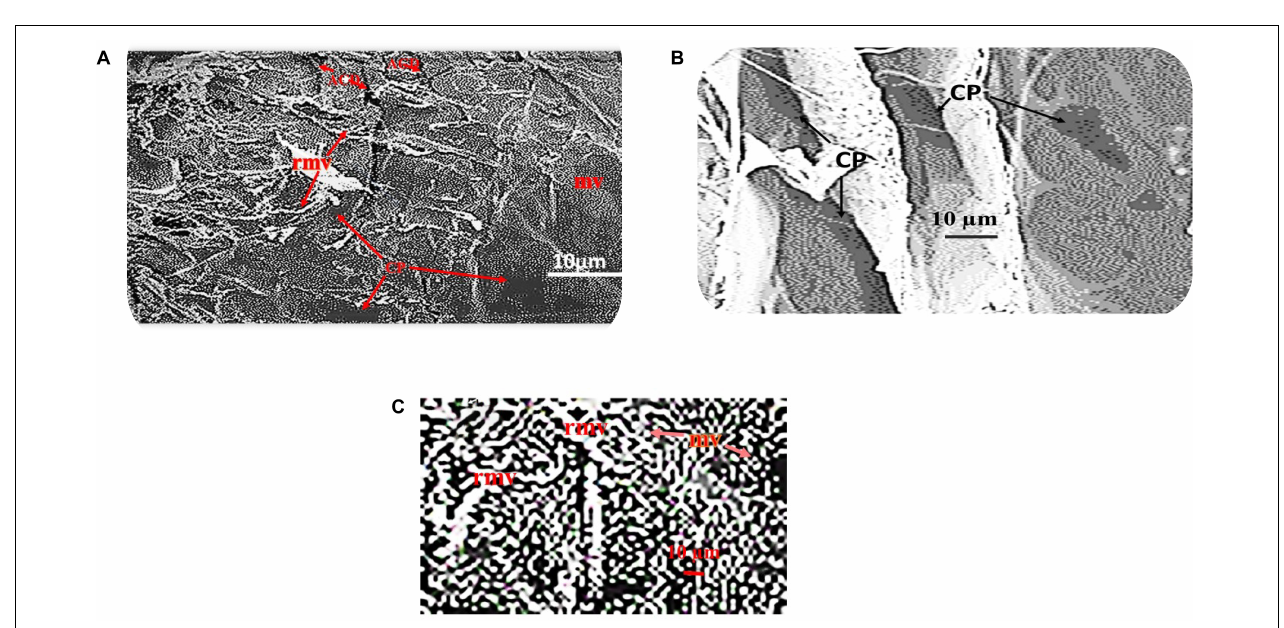
FIGURE 4 | (A) SEM micrograph shows microvilli (mv) on the amniotic epithelial surface of the processed PW-HAM wound dressing. Surface area of some amniotic epithelial surface lacking microvilli shows depressions (ACD) with pit-like structures (CP) and reticular ridges (rr). (B) SEM micrograph of the amniotic epithelial surface of the processed PW-HAM wound dressing indicate the occurrence of microvilli. Some epithelial surface lacks microvilli but have pit-like depressions (CP). (C) Microvilli (mv) or reticular microvilli (rmv) of the amniotic epithelial surface of the processed PW-HAM wound dressing are visible in a magnified SEM